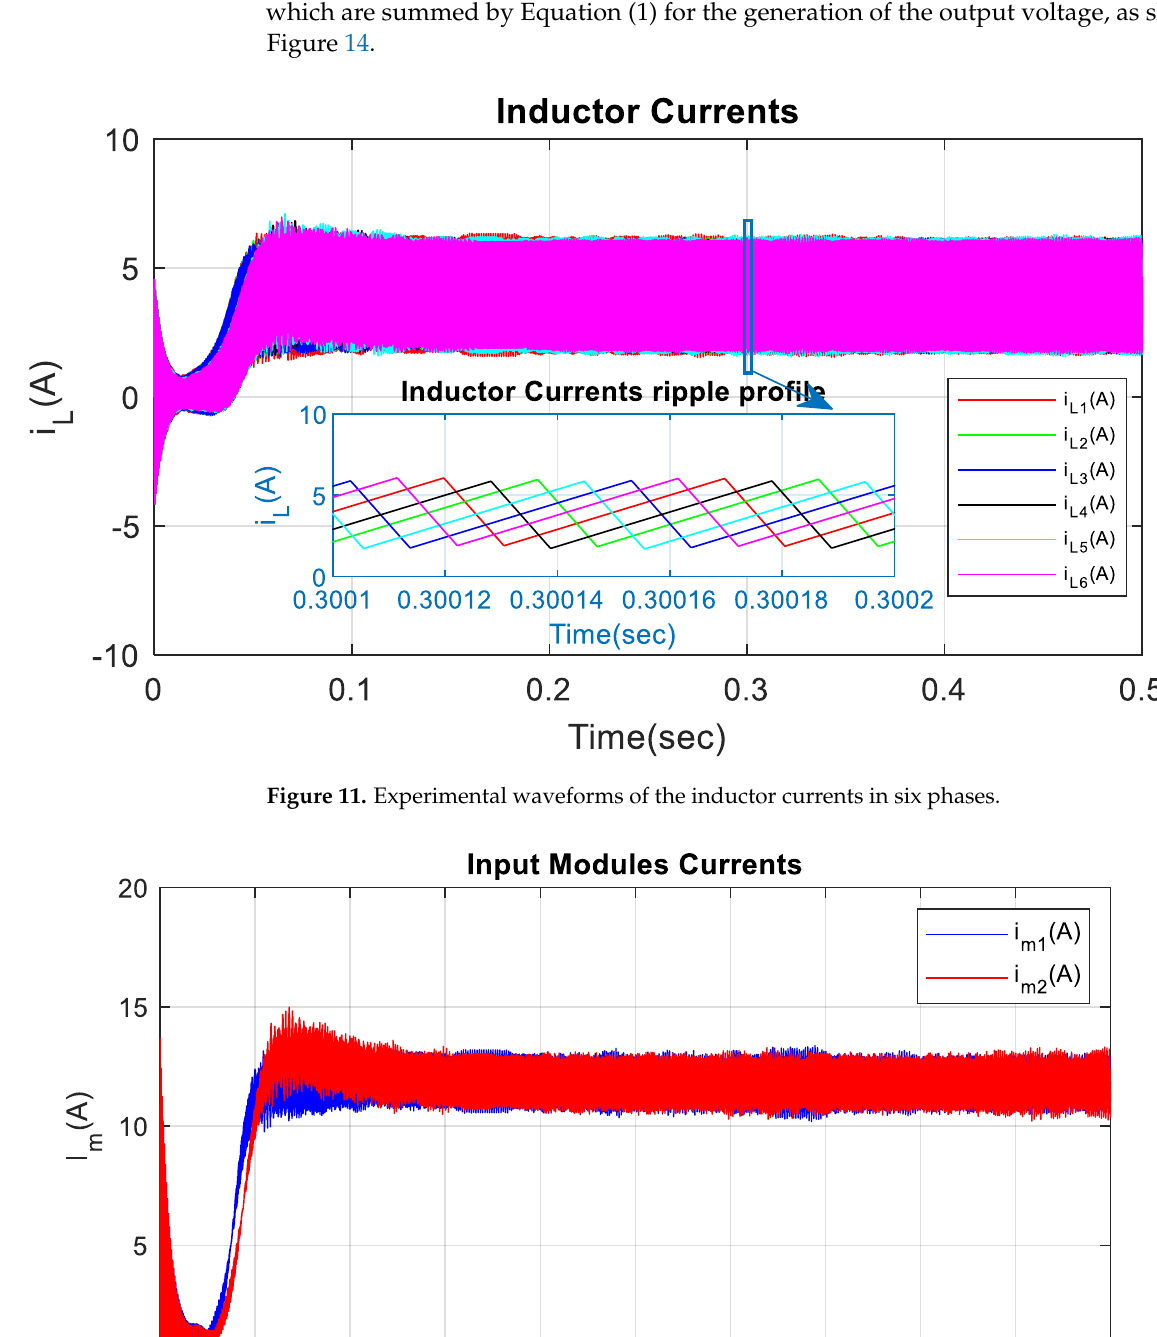
Figure 12. Experimental waveforms of the module input currents in the converter.